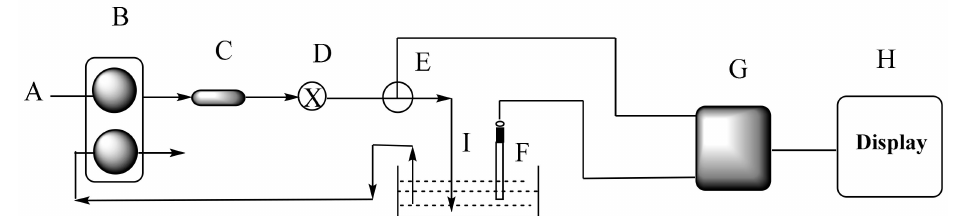
Figure 1. For the two channel FIA set up used for the determination of DCPIP: A, carrier tris bu ff er solution pH 7; B, peristaltic pump; C, pulse damper; D, sample injection valve; E, flow injection detector; F, reference electrode; G, data acquisition system; H, laptop computer; I, Petri